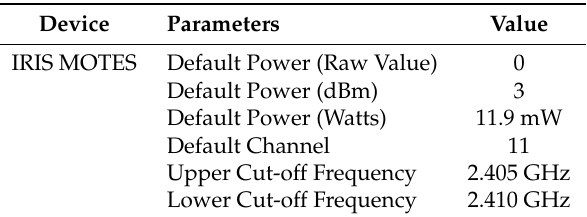
Table 4. IRIS Mote Configuration.